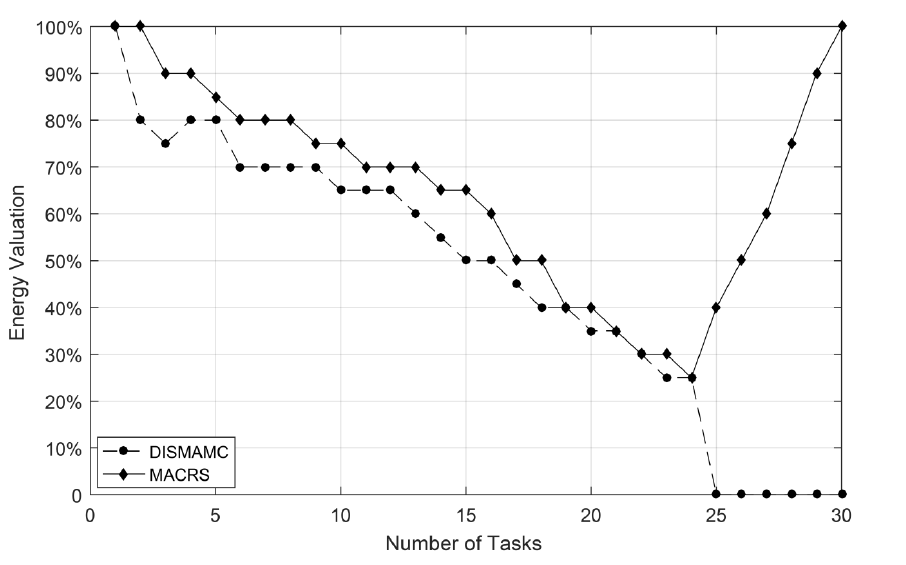
Figure 14. Handling Emergency Tasks.